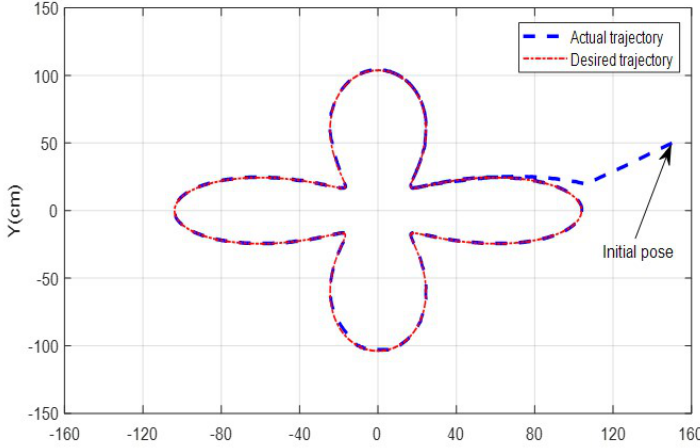
Figure 6. Experimental result of the polar-space rose curve trajectory. Figure 1. Scheme of the experimental procedure.